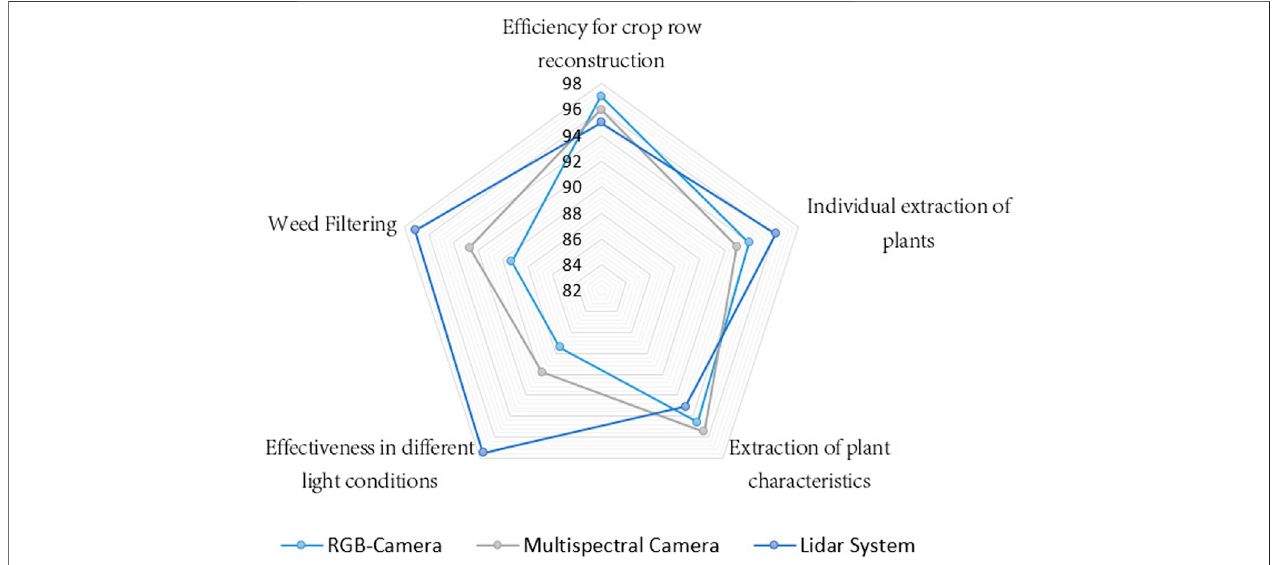
FIGURE 10 | Height and radius dimensions representation of the characterized